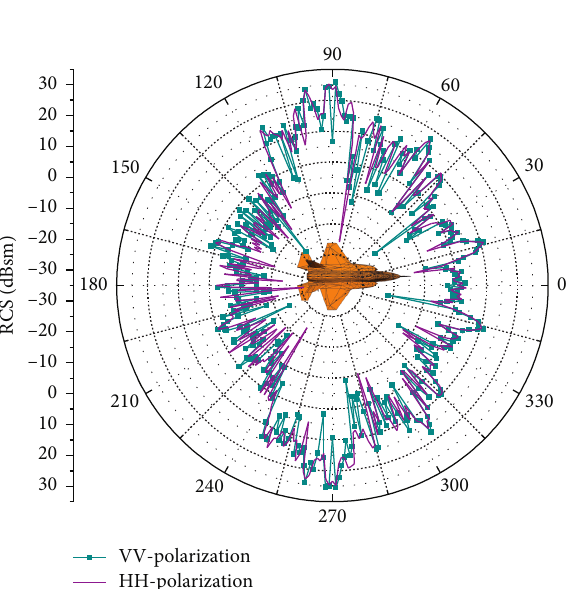
Figure 6: Monostatic RCS of airplane at 10